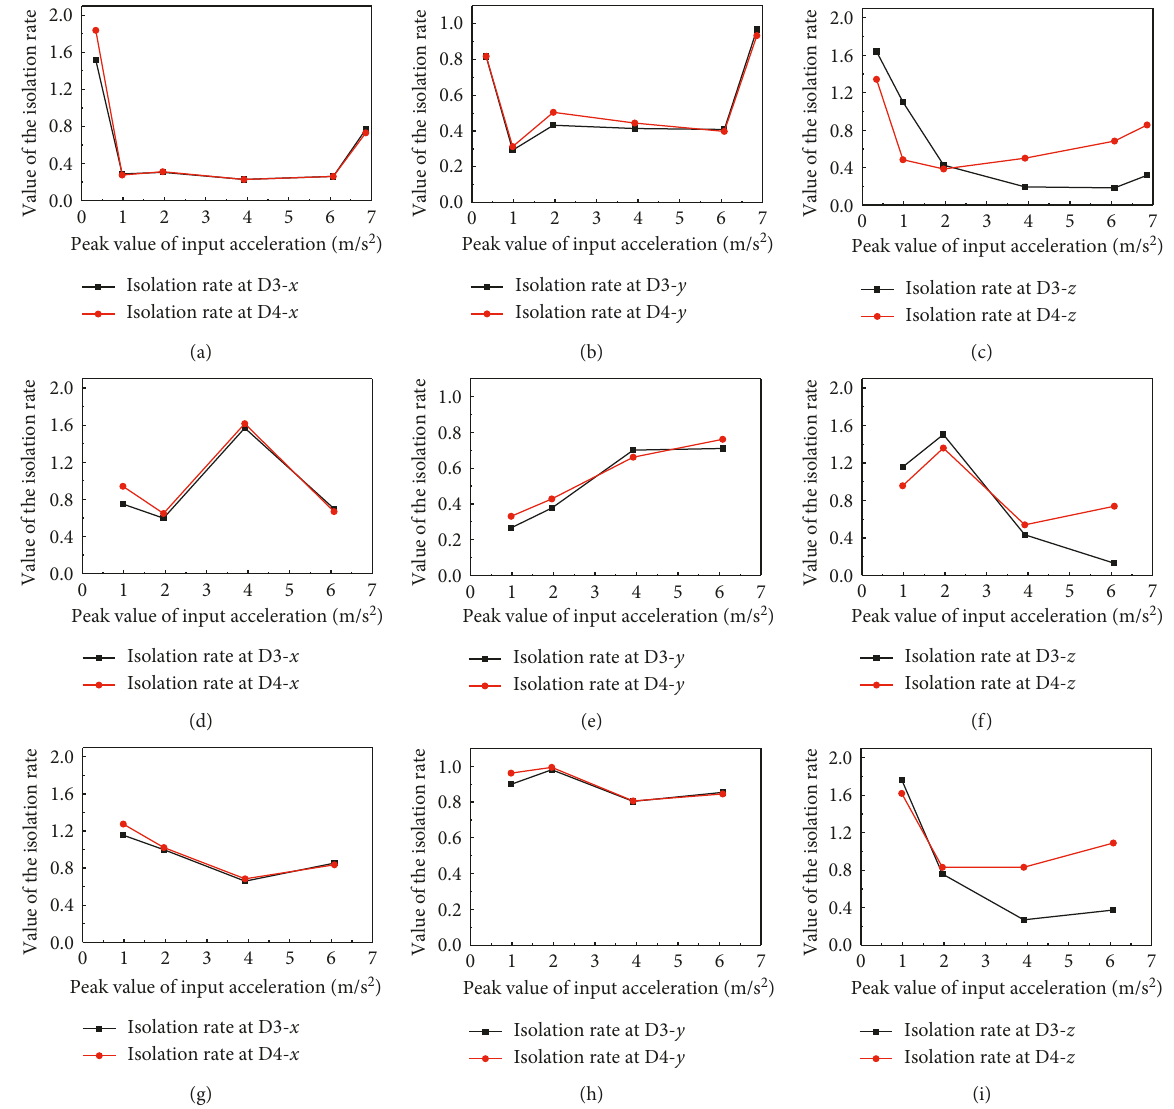
Figure 13: Vibration isolation rate of displacement. (a) Under Taft seismic motion in the x direction; (b) under Taft seismic motion in the y direction; (c) under Taft seismic motion in the z direction; (d) under 311 seismic motion in the x direction; (e) under 311 seismic motion in the y direction; (f) under 311 seismic motion in the z direction; (g) under Lsfx seismic motion in the x direction; (h) under Lsfx seismic motion in the y direction; (i) under Lsfx seismic motion in the z